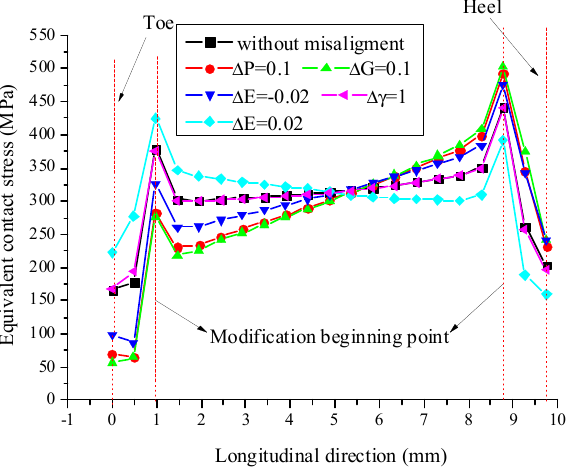
Figure 18. Contact stress distribution for the tooth end relief driving opinion (Case4) along the tooth width in different.